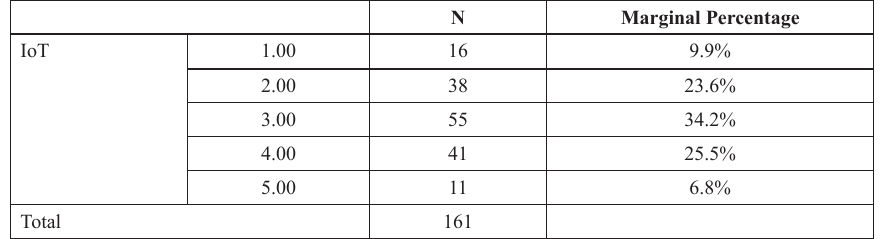
Table 2. The repetitions of the questionnaires and case processing